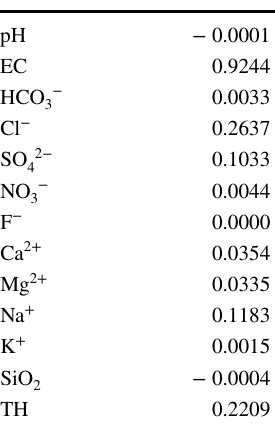
Table 7 Loadings of the Original originally correlated variables for PC1